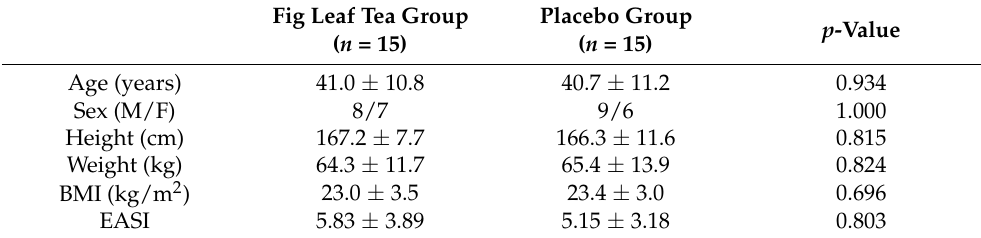
Figure 3. Flow chart for the study subjects. The number of participants enrolled, allocated, followed and analyzed, is shown using CONSORT-SPI 2018 Flow Diagram. Table 2. Background of study participants.